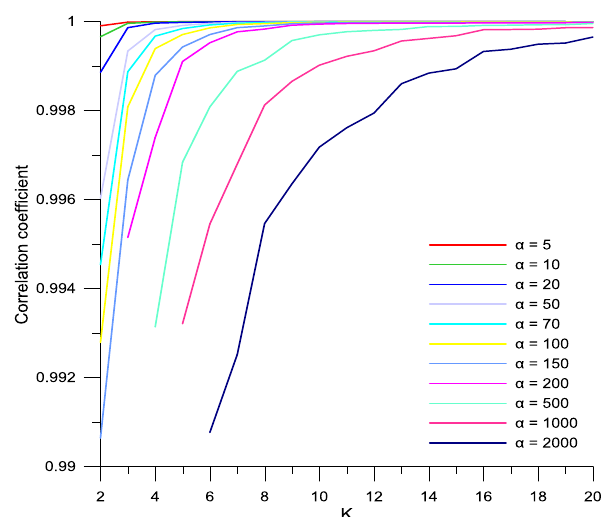
Figure 5. Correlation relationship between original water demand time series and reconstructed time series for different K and α values.